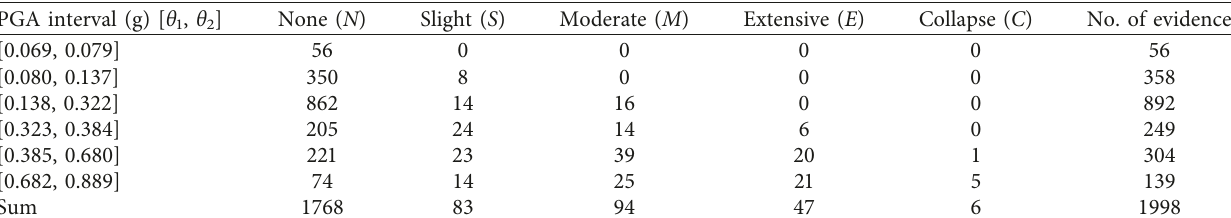
Figure 3: Empirical fragility curves determined by maximum likelihood estimation using different distribution functions. At each figure, curves from top to bottom are fragility curves for damage state subsets of S , M , E , and C , respectively. (a) Lognormal CDF. (b) Extreme type I (Gumbel) CDF. (c) Extreme type II (Frechet) CDF. Table 2: Number of damage information at each damage state in PGA